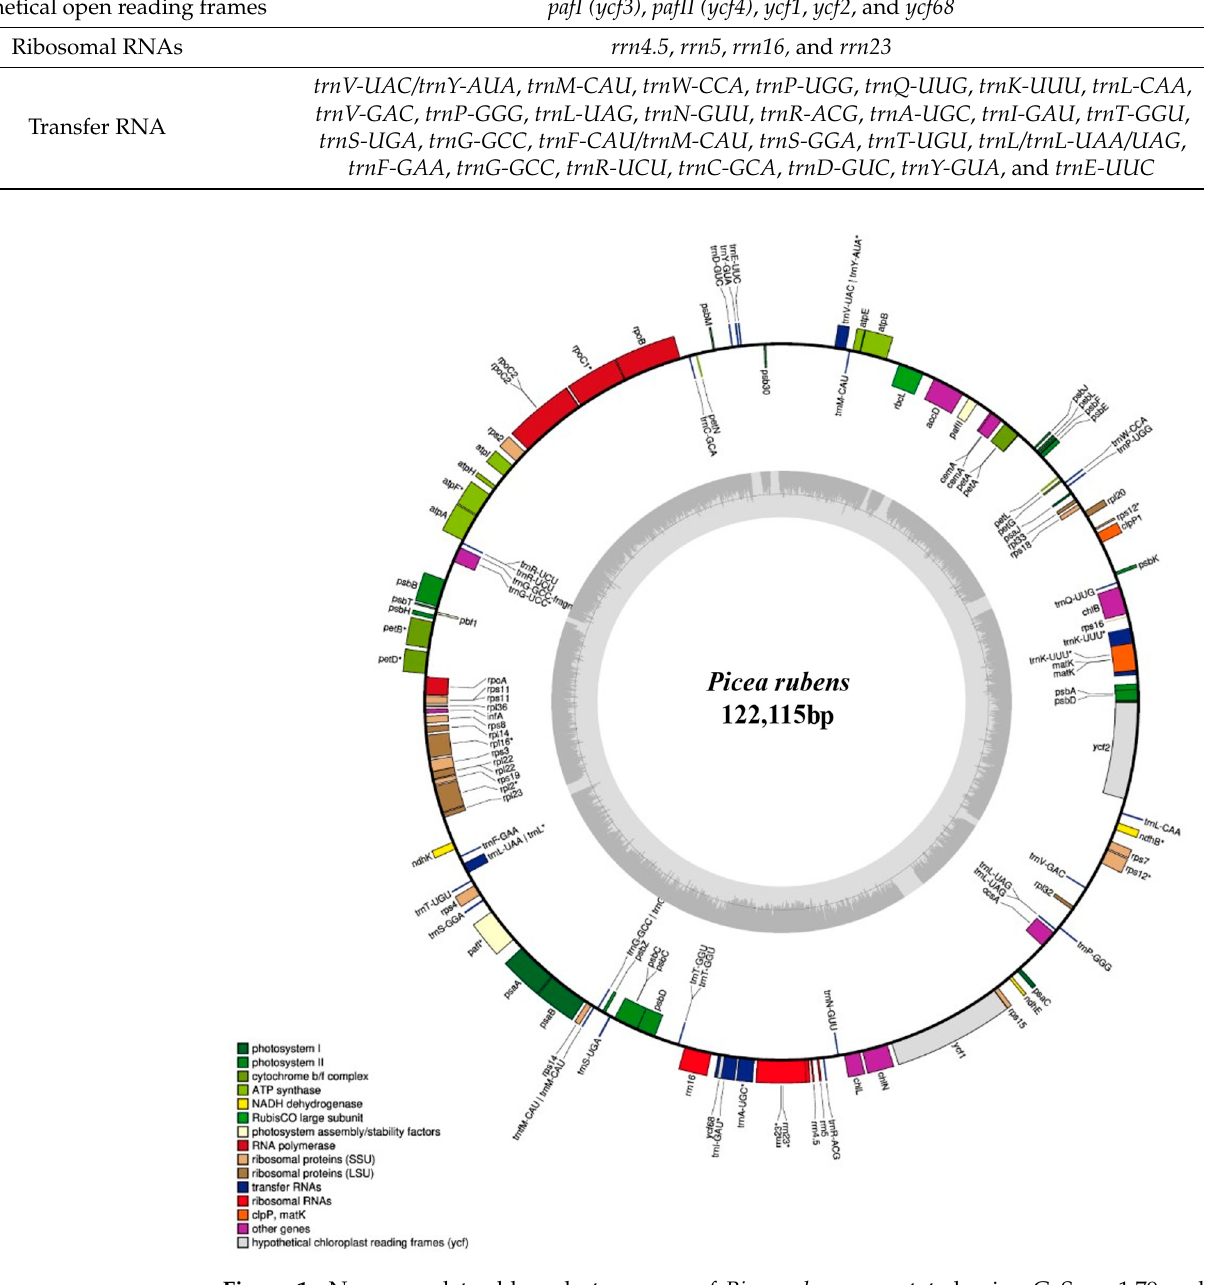
Figure 1. Near-complete chloroplast genome of Picea rubens , annotated using GeSeq v1.79 and organized using OGDRAW version 1.3.1 [(*) asterisk represents intron-containing genes in organelle genomes]. The ndh genes in the figure are truncated pseudogenes. Table 2. Gene contents of the P. rubens chloroplast genome based on genome annotation.